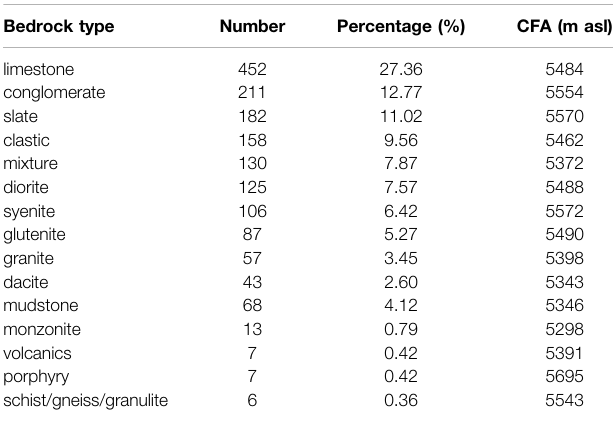
TABLE 4 | CFA against